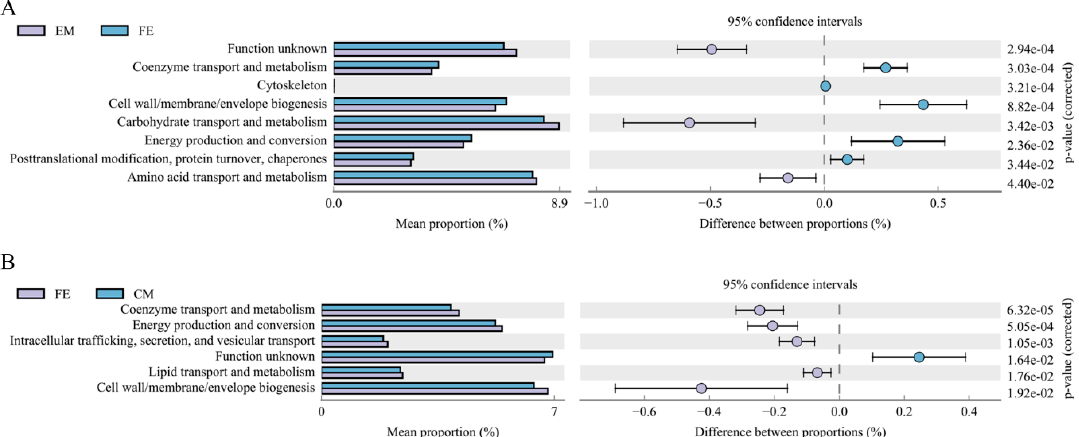
Figure 6. COG function analysis diagram. ( A ) comparison between entire male pigs and female pigs; ( B ) comparison between female pigs and castrated male pigs.